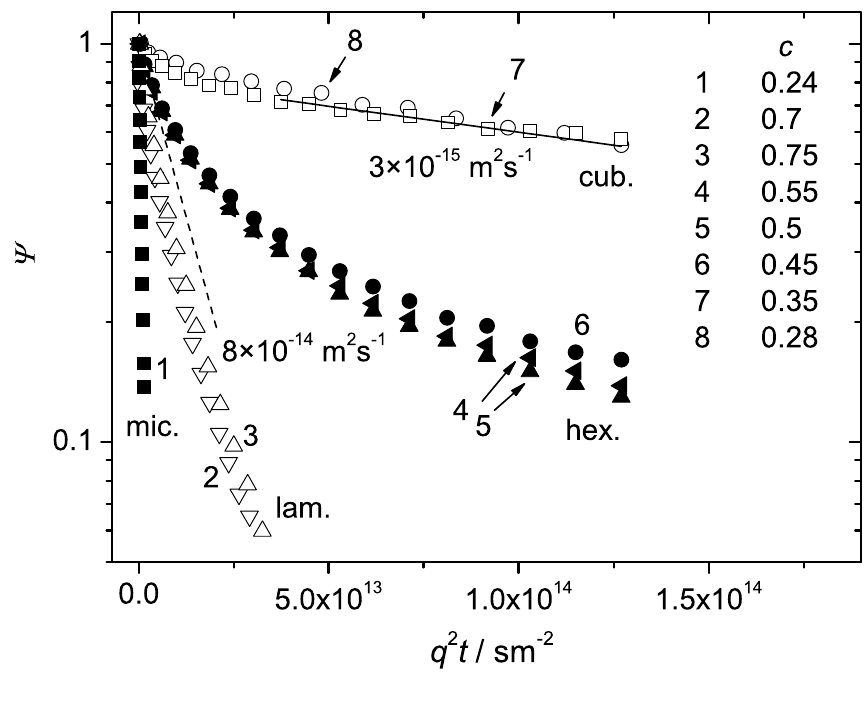
Figure 4. The normalized spin echo diffusion attenuations of the triblock copolymer P123 in water for different concentrations at T = 23 ◦ C. The polymer weight fractions for the curves 1–8 were 0.24, 0.7, 0.75, 0.55, 0.5, 0.45, 0.35 and 0.28, respectively. The solid line refers to the initial slope of the slow component. The dashed lines is the guide for the